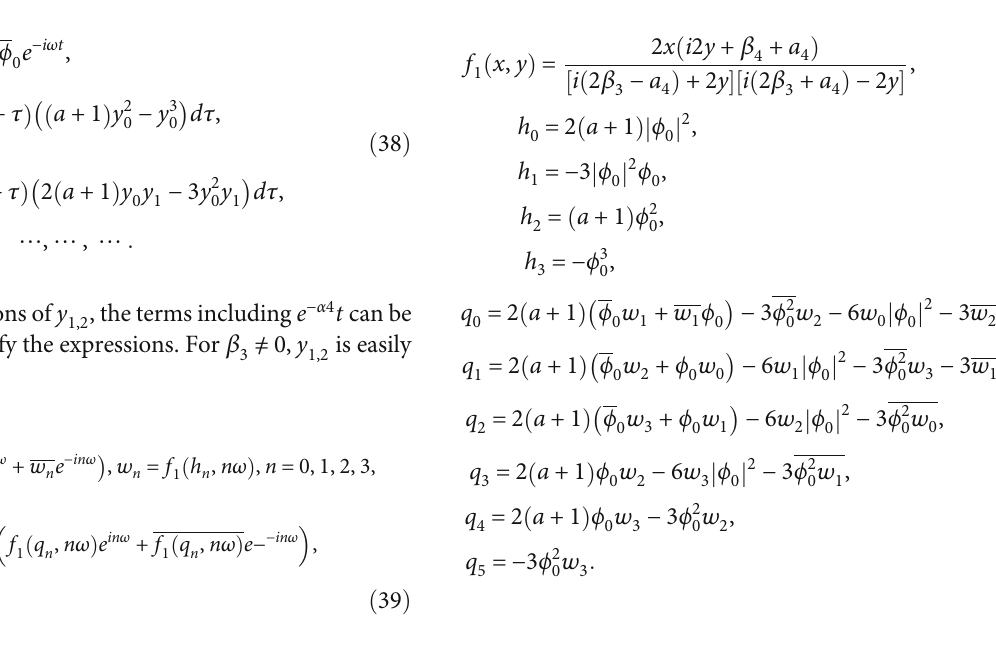
with c = 0 : 18 . The initial conditions are taken as u 2,4